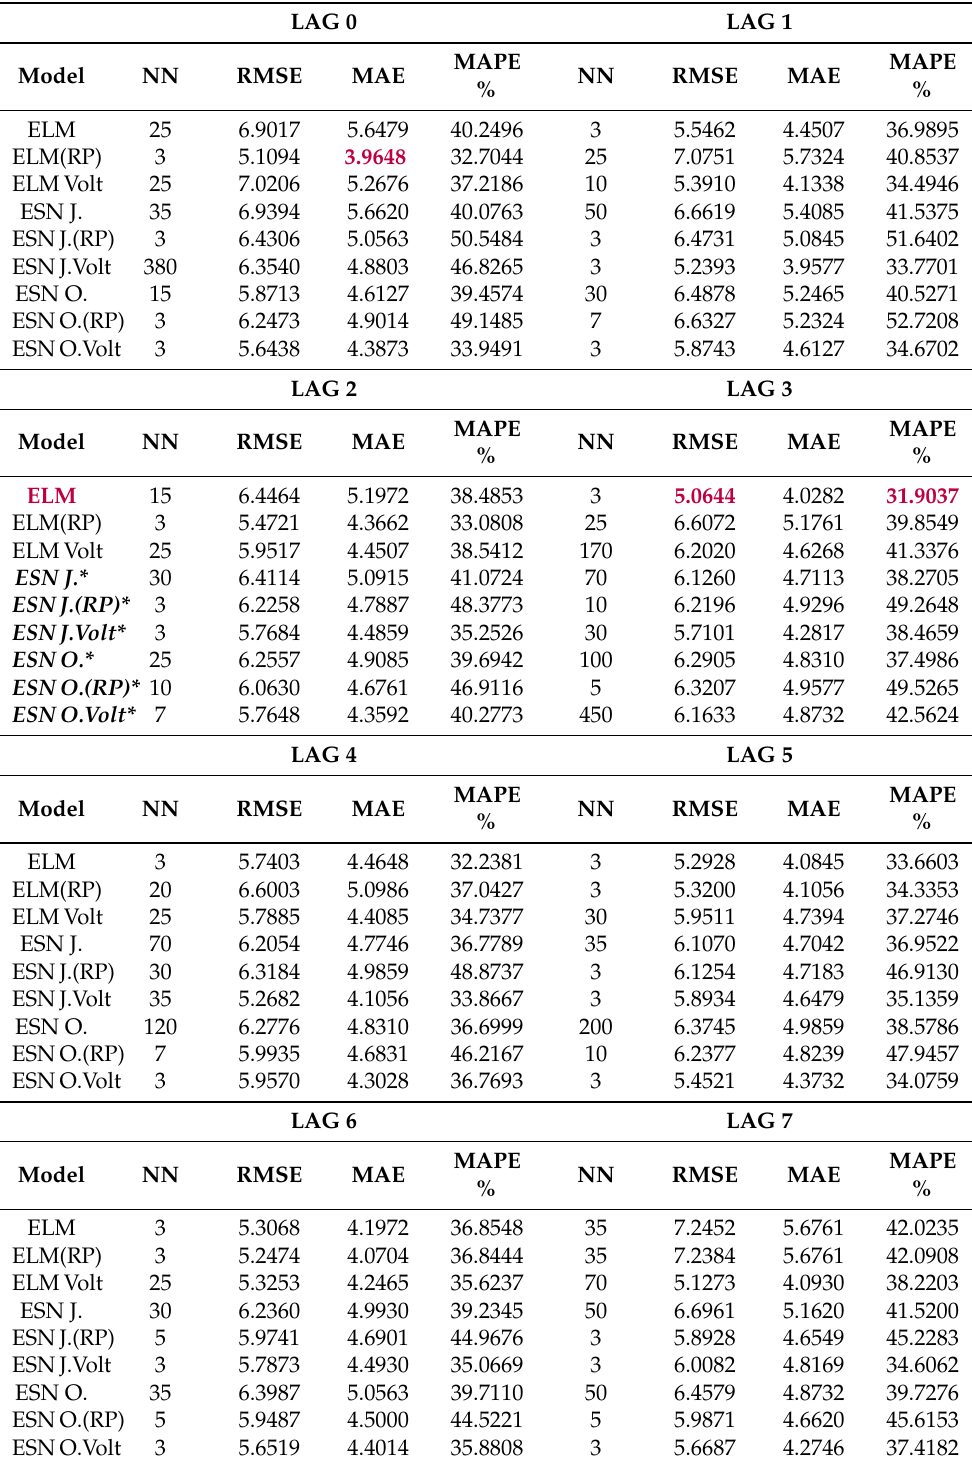
Table 4. Results for Campinas (Number of neurons-NN, RMSE, MAE and MAPE for each model and